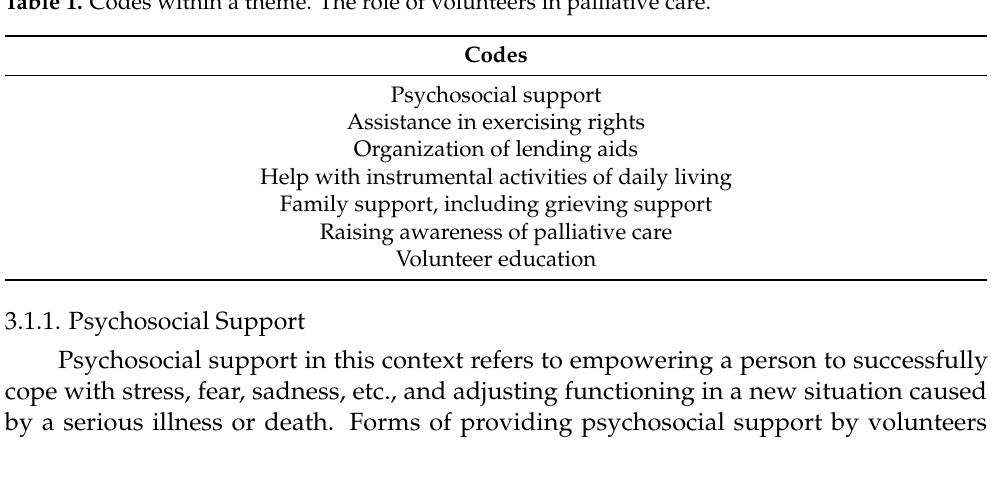
Table 1. Codes within a theme. The role of volunteers in palliative